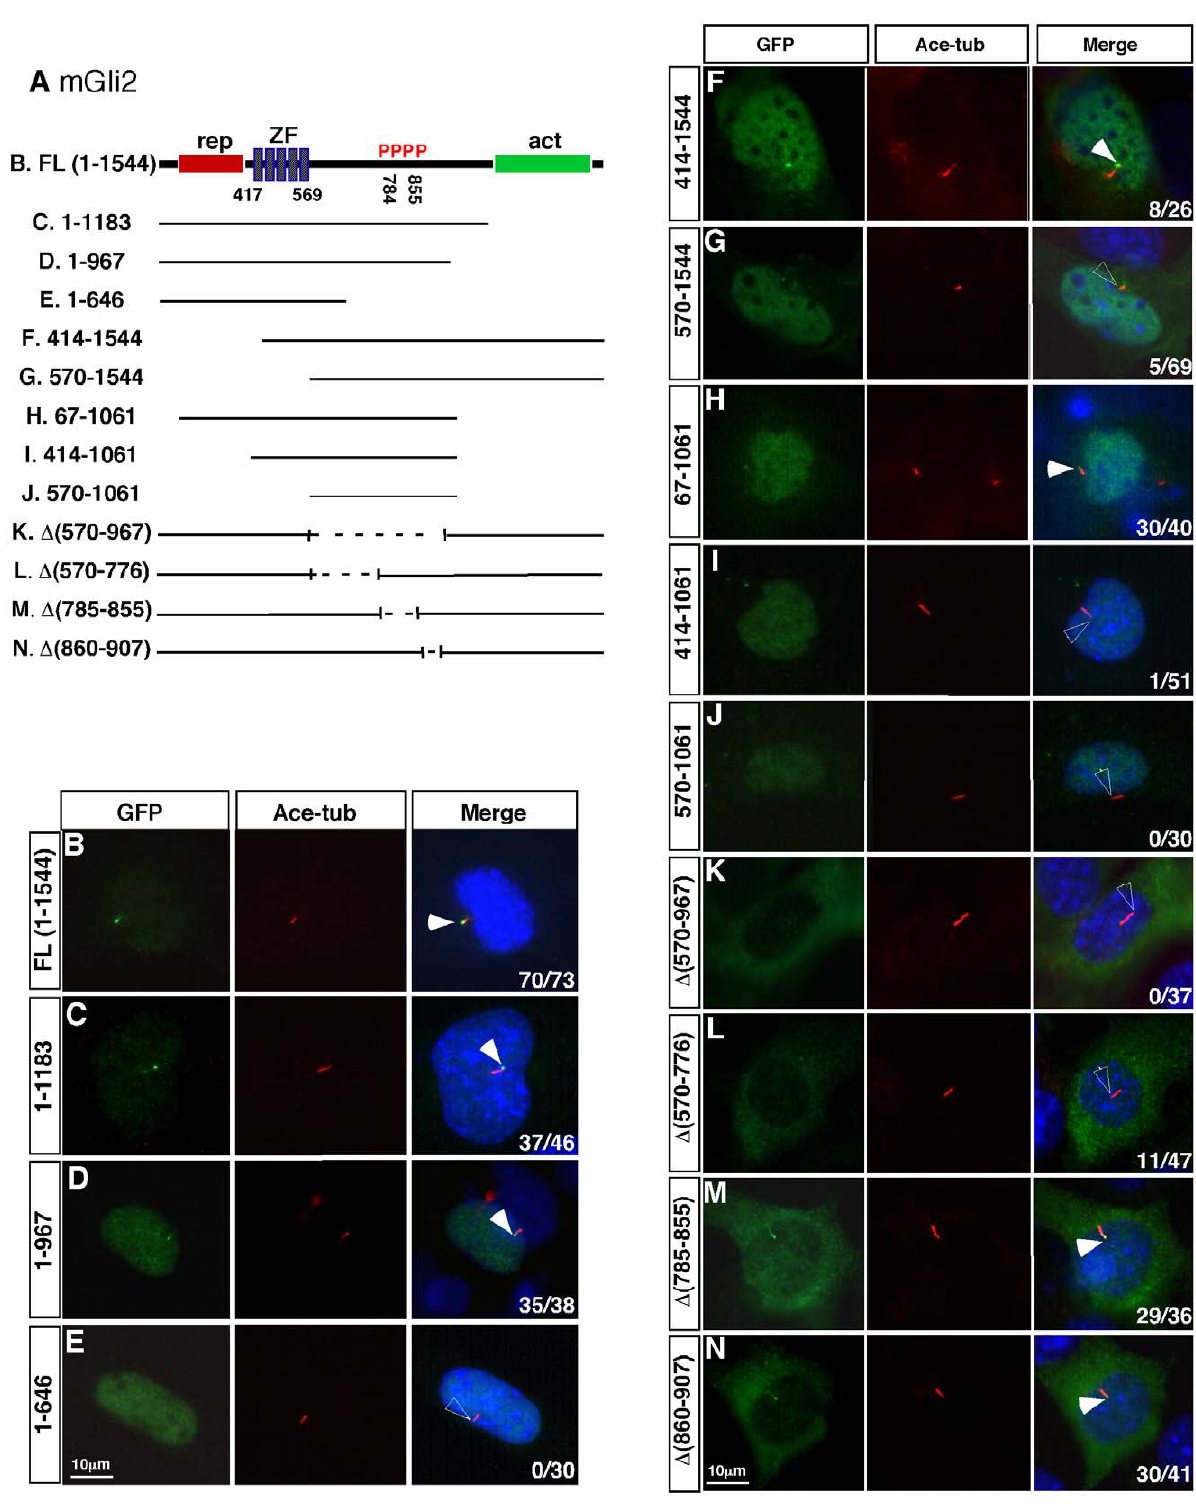
Figure 1. A central domain of Gli2 is essential for its ciliary localization. (A) Mouse Gli2 is composed of an N-terminal region (1–416), five zinc-finger motifs (ZF; 417–569) and a C-terminal region (570–1544). Transcriptional repressor (rep: red box) and activator (act: green box) activities are found in the N- and C-terminal regions, respectively. Four clusters of phosphorylation (P) target sites are located between residues 785–855. Schematics are shown for the deletions made in the Gli2 variants used in B–N. (B–N) Immunofluorescent images of MEFs transfected with GFP-tagged Gli2 variants are shown. Cilia are labeled with acetylated tubulin and nuclei are stained with DAPI. In the merged images, filled arrowheads indicate GFP-Gli2 at the tips of the cilia, unfilled arrowheads indicate the tips of cilia without GFP-Gli2 accumulation. Numbers at the lower-right corners of each image indicate numbers of cells with ciliary localization of GFP-tagged proteins over total numbers of transfected cells.